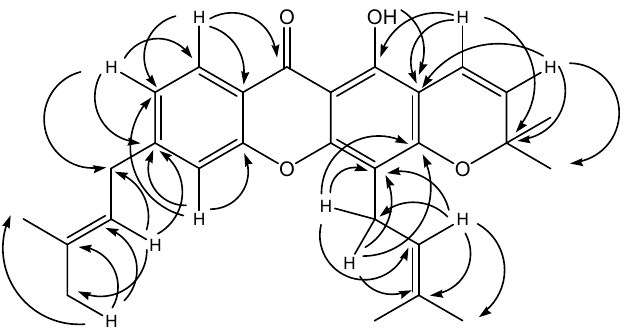
Figure 2. Selected HMBC correlations of 1a